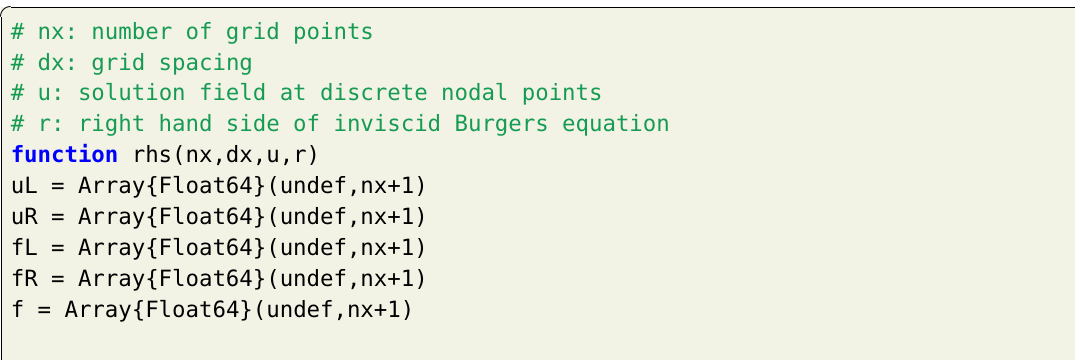
Listing 13. Implementation of Julia function to calculate the right hand side of inviscid Burgers equation using Riemann solver based on Rusanov scheme.